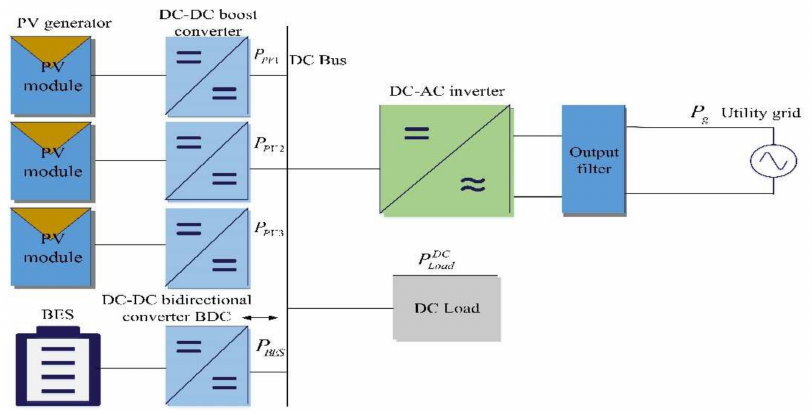
Figure 1. System configuration/control of the grid connected PV/BES with local AC and DC